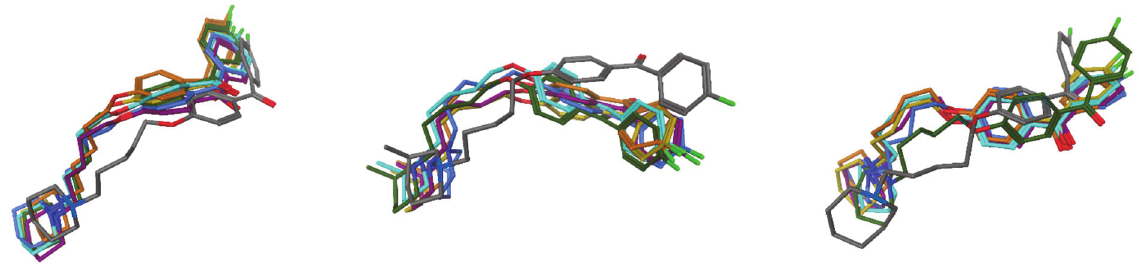
Figure 6 . Orientations of 6 ( left ), 16 ( middle ) and 30 ( right ) during the MD simulations in 0 ps—grey, 100 ps—green, 200 ps—teal, 300 ps—green, 400 ps—violet, 500 ps—orange, 600 ps—yellow.